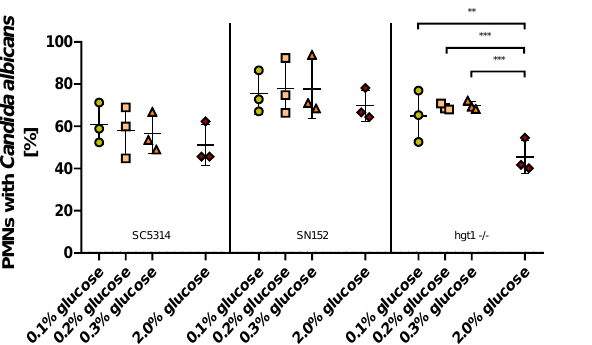
Figure 2. Phagocytosis of opsonized Candida albicans yeast cells grown at different glucose concentrations overnight by polymorphonuclear leukocytes (PMNs). Yeast cells of wild type (SC5314), parental (SN152), and HGT1 knockout (hgt1-/-) strains were incubated in yeast peptone medium with either 0.1%, 0.2%, 0.3%, or 2% glucose, opsonized with 40% normal human serum (NHS) and labeled with fluorescein isothiocyanate (FITC). Freshly isolated PMNs were added and their membrane was labeled with AlexaFluor ® 647-conjugated wheat germ agglutinin (WGA). The percentage of double-positive PMNs ( A ) was measured using fluorescence-activated cell sampler (FACS) Verse with BD software and the amount of phagocytosed Candida albicans yeast cells is shown as FITC mean ( B ). The results shown were gained by three independently performed experiments (mean ± SD). Stars (*) indicate the level of significance for an adjusted p -value, comparing pairs of groups using a Tukey post-hoc analysis after the one-way ANOVA reported significance.